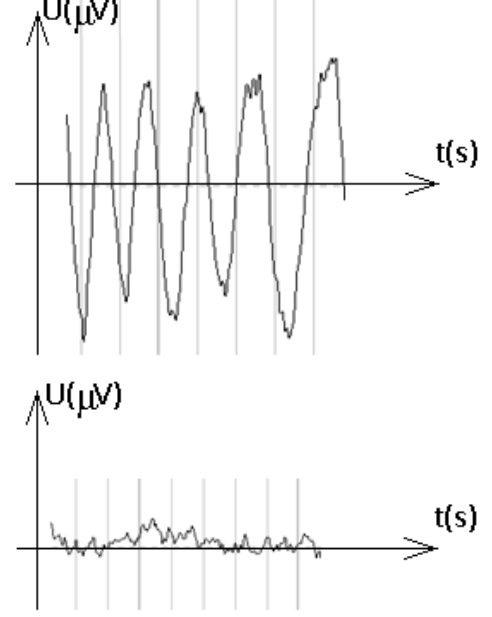
Fig 7 . Eyeballs moving. Top – original, bottom –